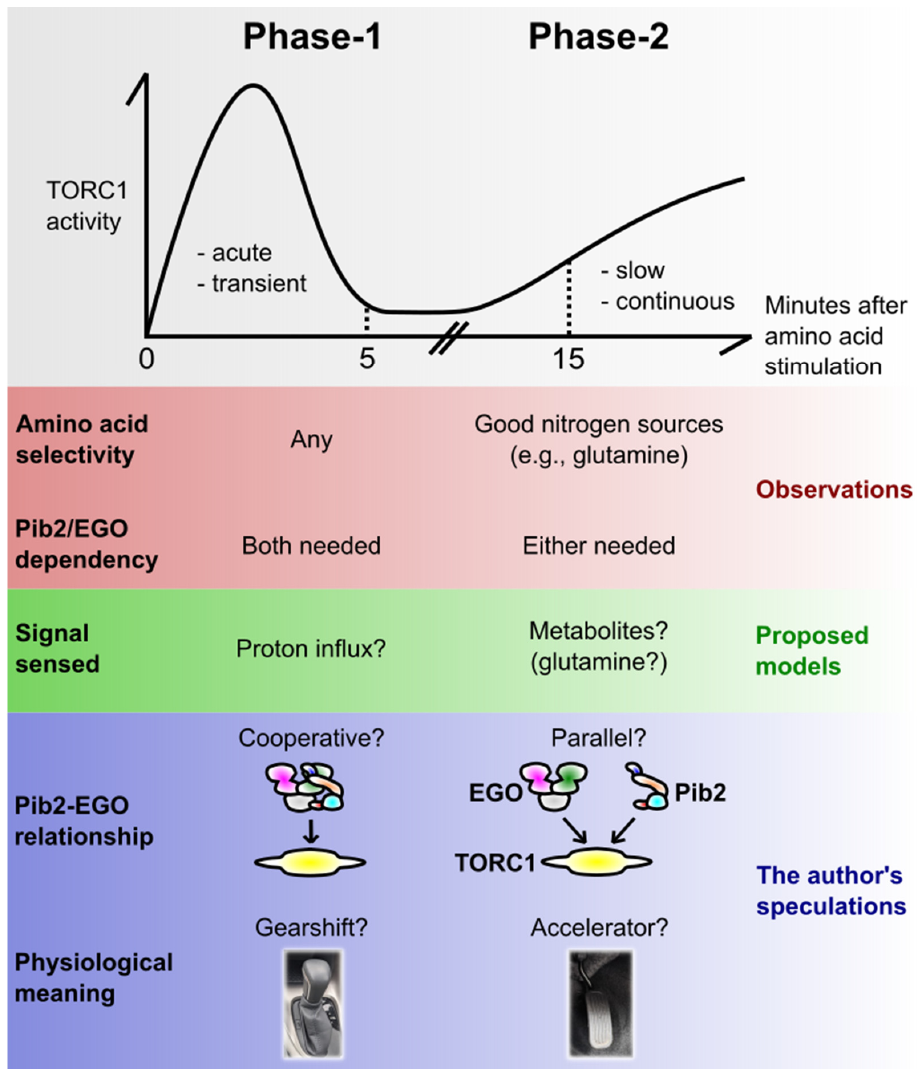
Figure 2. The dual-phase activation of yeast TORC1 by amino acids. Yeast TORC1 responds to amino acids with two distinct phases over time: the acute, transient pulse (here coined Phase-1) and the slow, continuous activation (Phase-2). This figure summarizes the observed distinct natures, proposed or speculative mechanistic models for the two phases. See the main text for details.